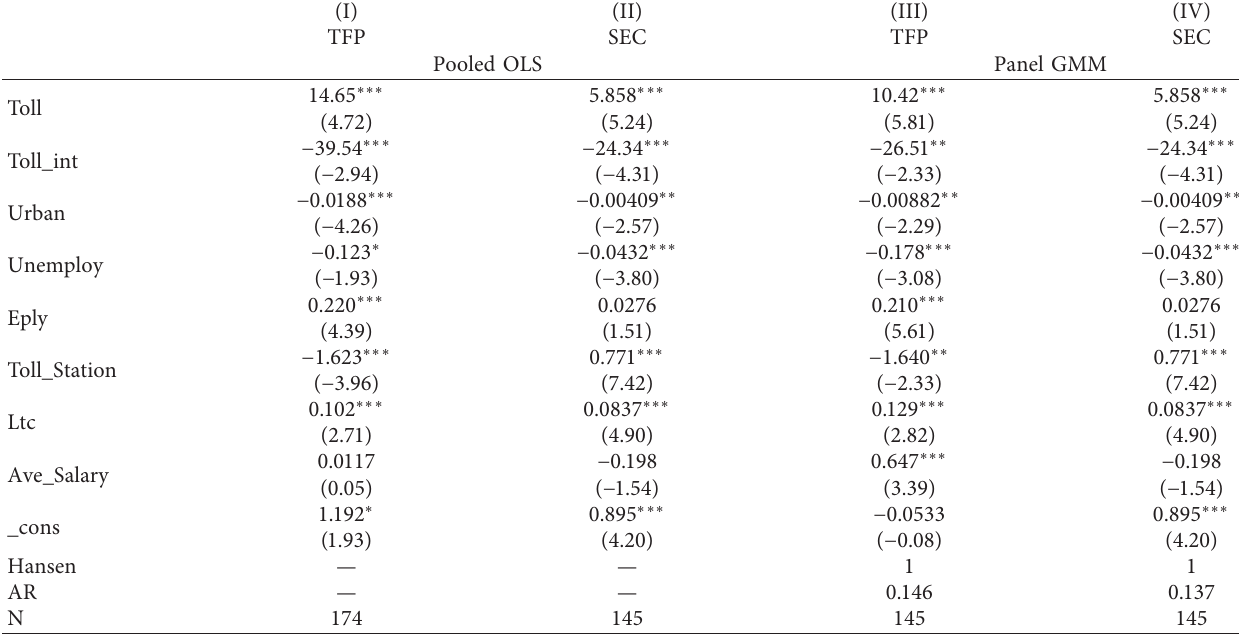
Table 6: Parameter estimation